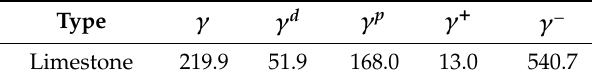
Table 5. SFE and its component of limestone (mJ / m 2 ).